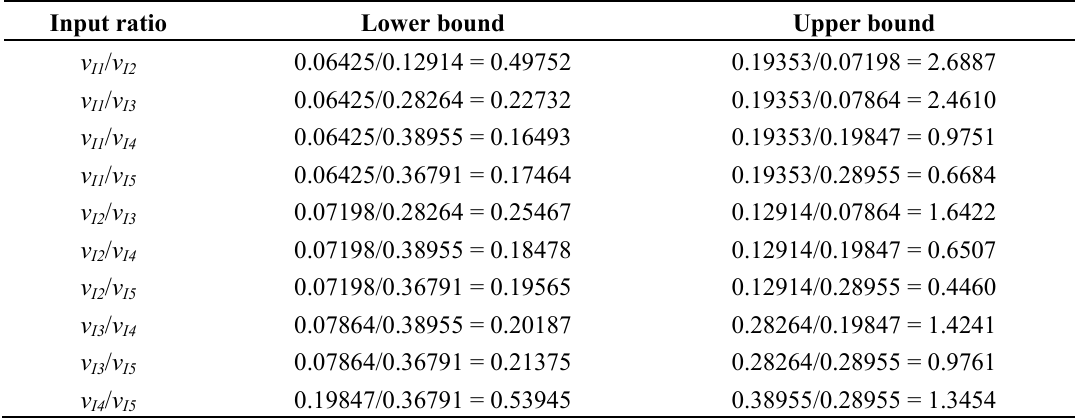
Table 11. Assurance ranges (AR) for inputs.